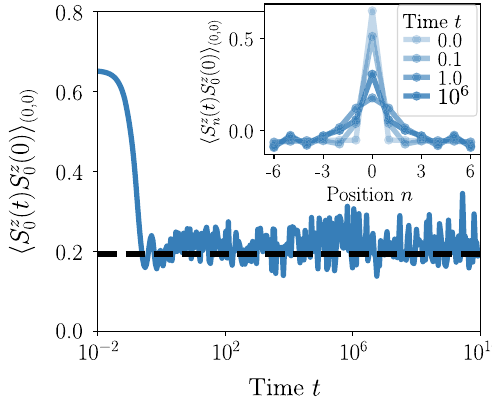
FIG. 15. Evolution of the autocorrelation function h S z 0 ð t Þ S z 0 i for the Hamiltonian H 3 and system size N ¼ 13 , where longer timescales t ∼ 10 10 can be numerically reached. We observe the same qualitative behavior as in Fig. 1.